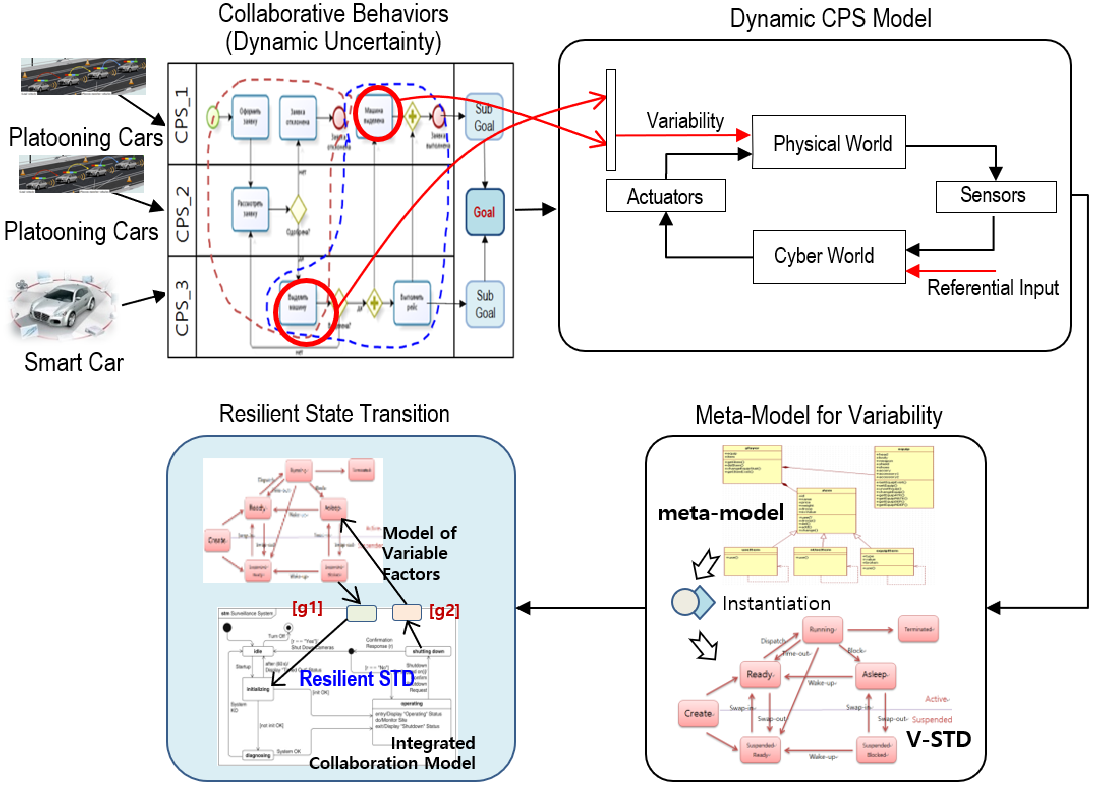
Figure 3. Proposed approach.